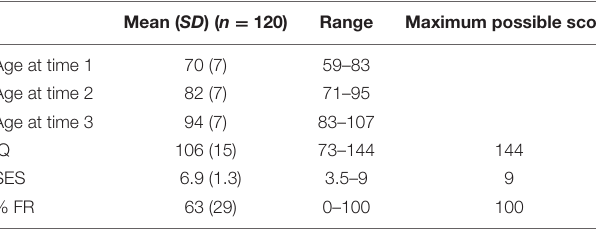
TABLE 1 | Descriptive characteristics of the